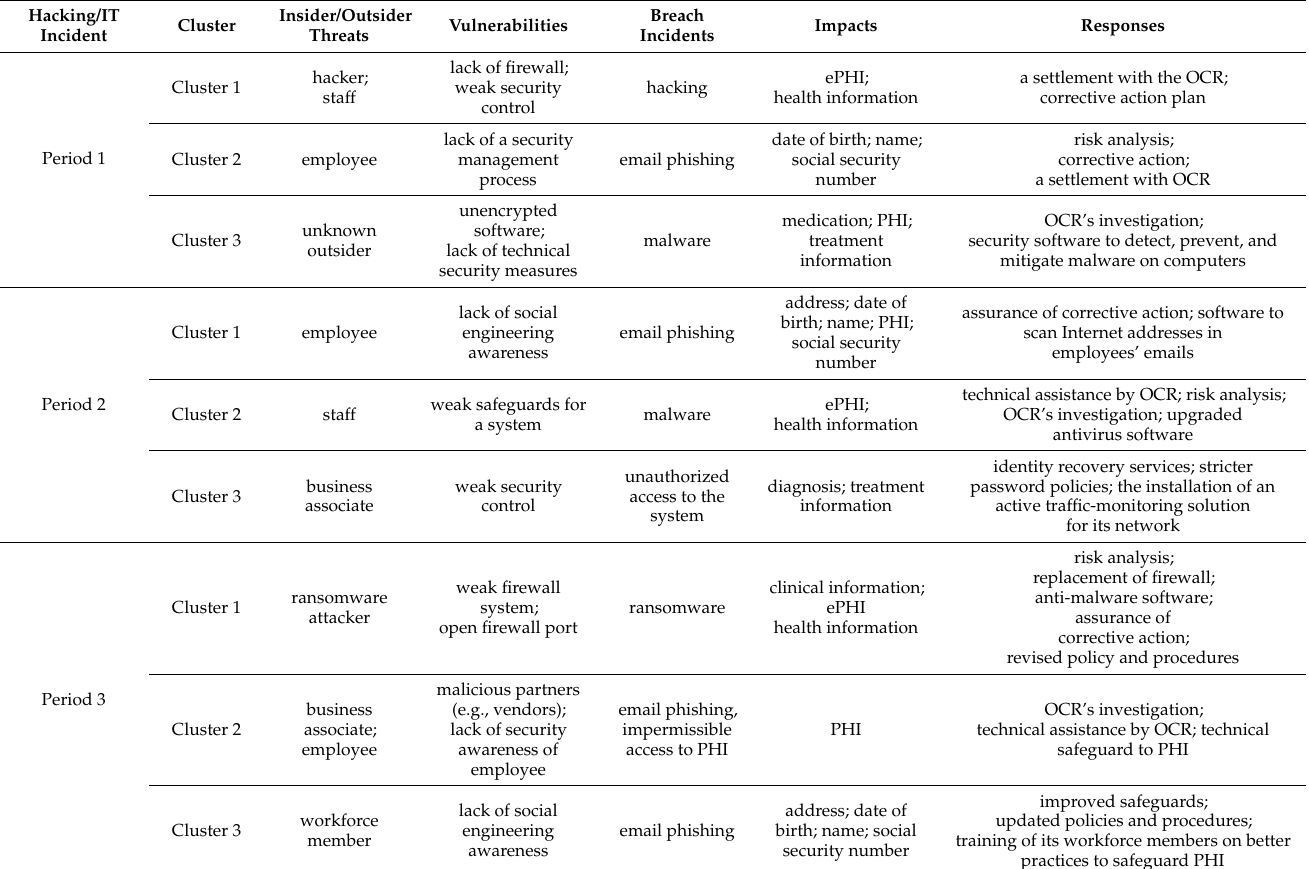
Table 2. Insider/Outsider Threats, Vulnerabilities, Breach Incidents, Impacts, and Responses in Hacking/IT